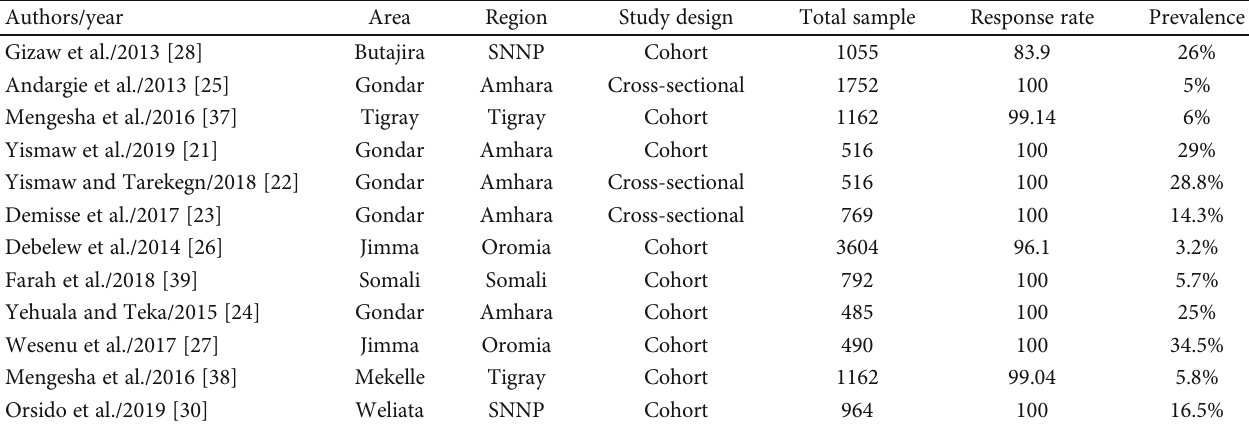
Table 1: Characteristics of the included